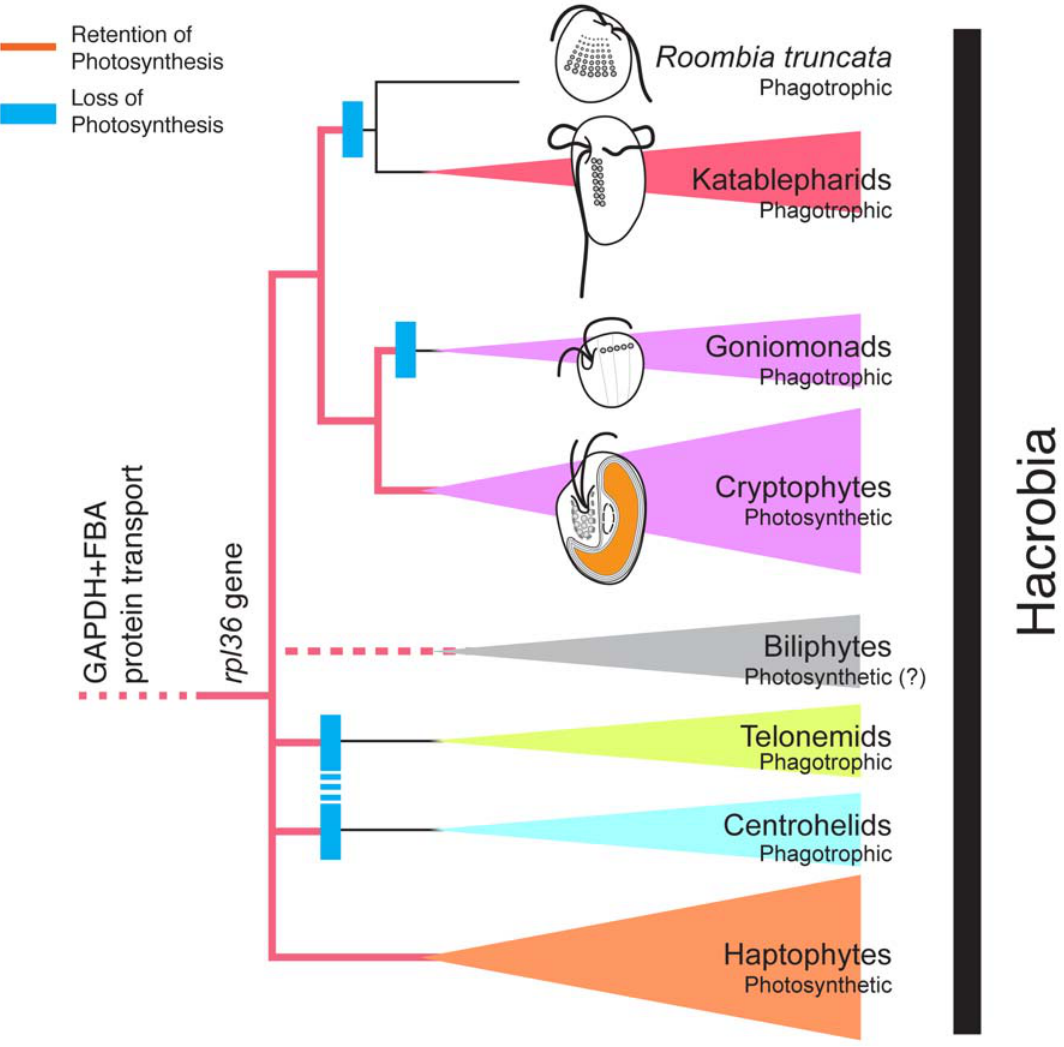
Figure 7. Schematic diagram of Hacrobia. Red lines denote the retention of photosynthesis. Blue boxes denote the losses of photosynthesis. If the monophyly of telonemids and centrohelids is the case as was suggested in Burki et al. [29], the number of losses of photosynthesis may be three, instead of four.